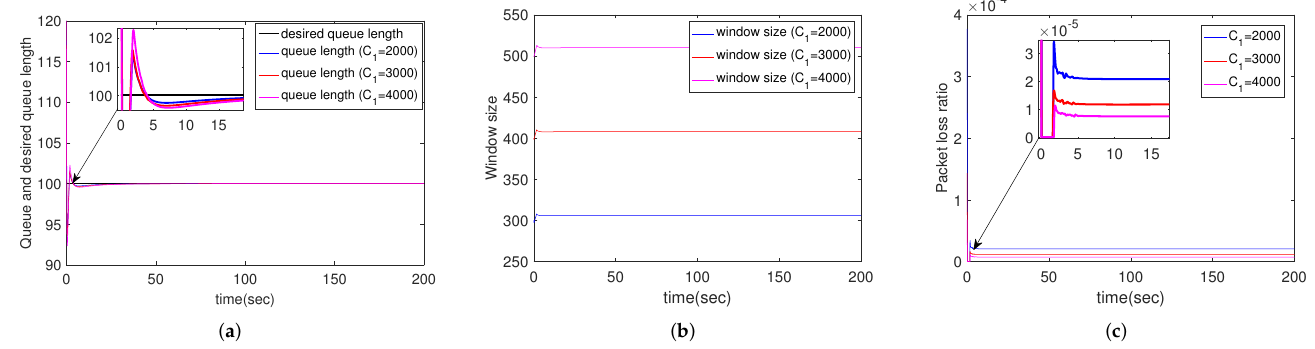
Figure 3. Simulation results of multiple routers using CCAIB for different link capacities. Columns from left to right show the performance of CCAIB in ( a ) queue length stability, ( b ) window size and ( c ) packet loss ratio in the